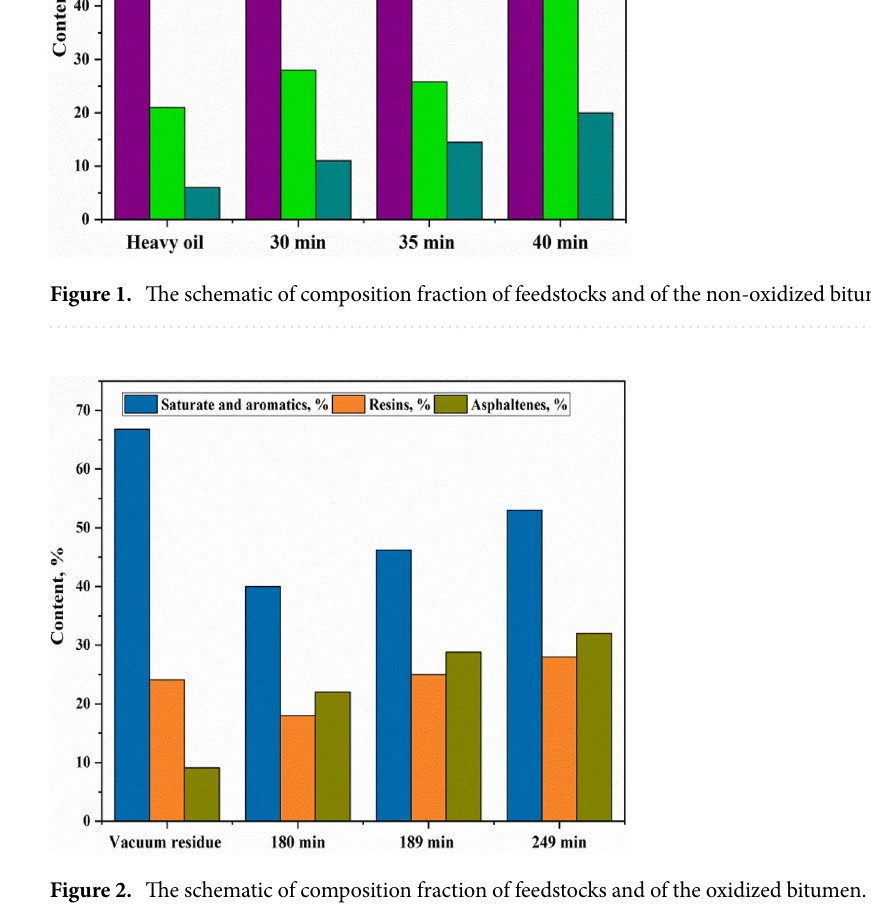
Figure 2. The schematic of composition fraction of feedstocks and of the oxidized